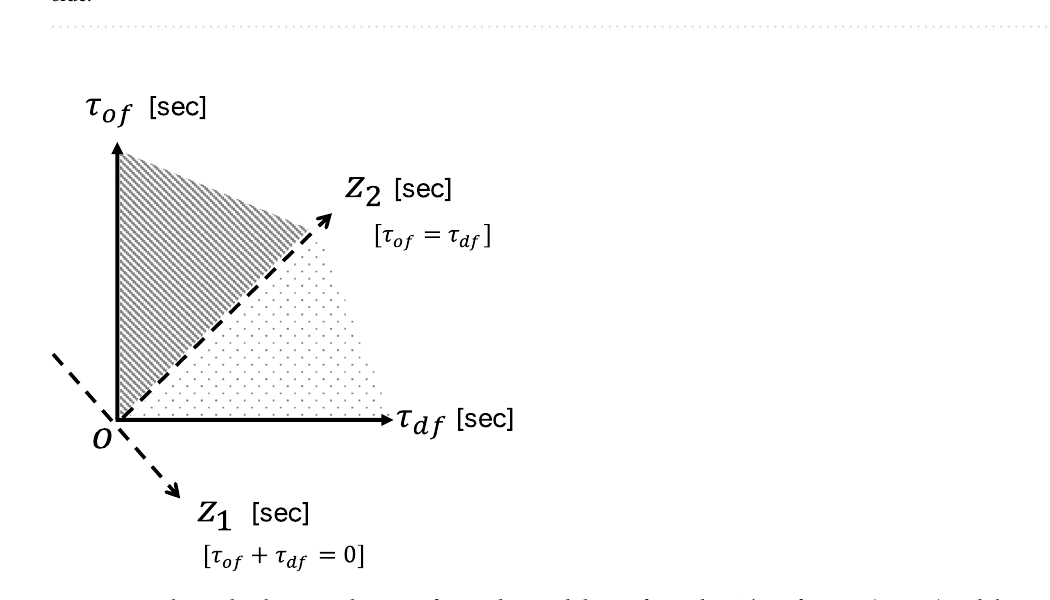
Figure 2. Relationship between the axes of τ of and τ df and those of z 1 and z 2 . The safe space ( z 1 > 0 ) and the risky space ( z 1 < 0 ) for the offense team are shown by